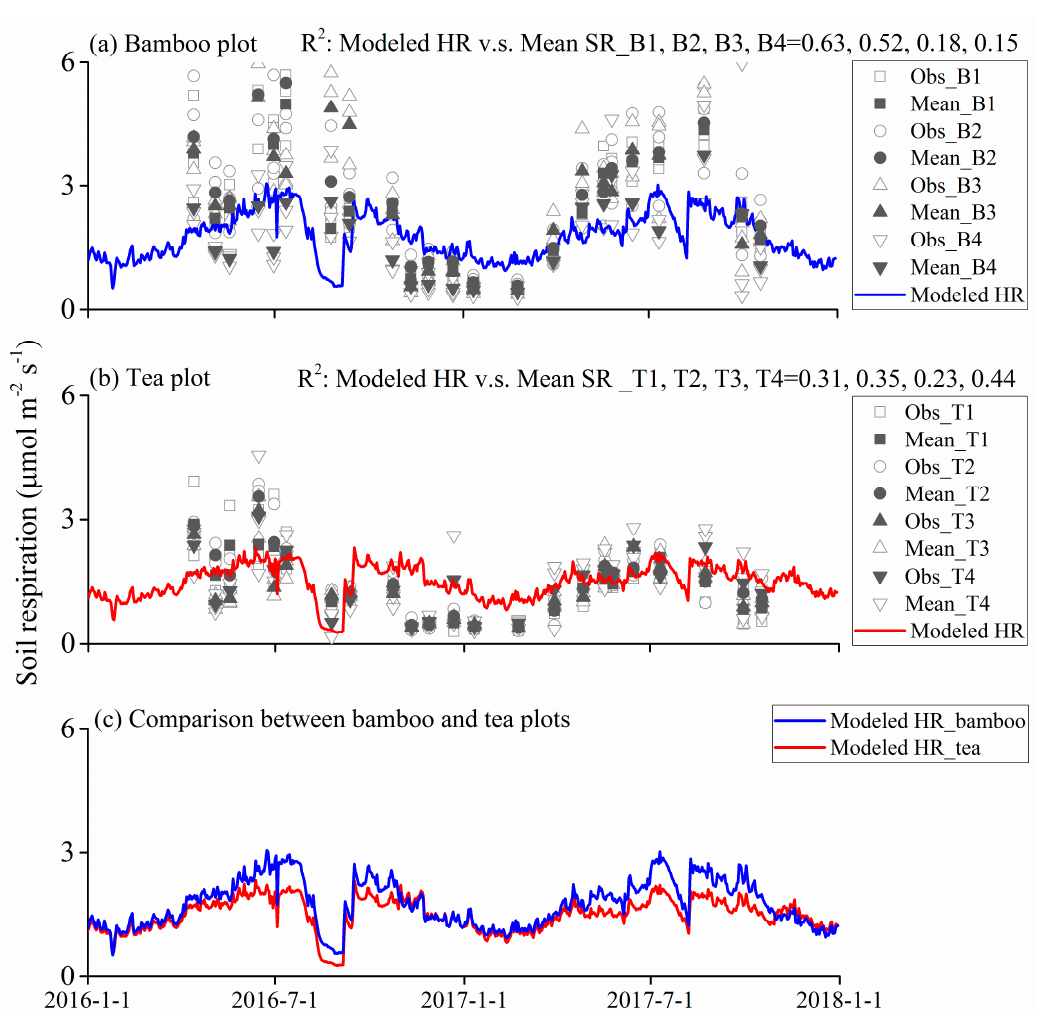
Figure 8. Observed soil respiration (SR) and modeled heterotrophic respiration (HR) at the bamboo ( a ) and tea ( b ) plots. Panel ( c ) shows the comparisons between the modeled HR at the two plots. The drought in August 2016 (monthly precipitation: 16.7 mm) caused a 55% decrease in the mean